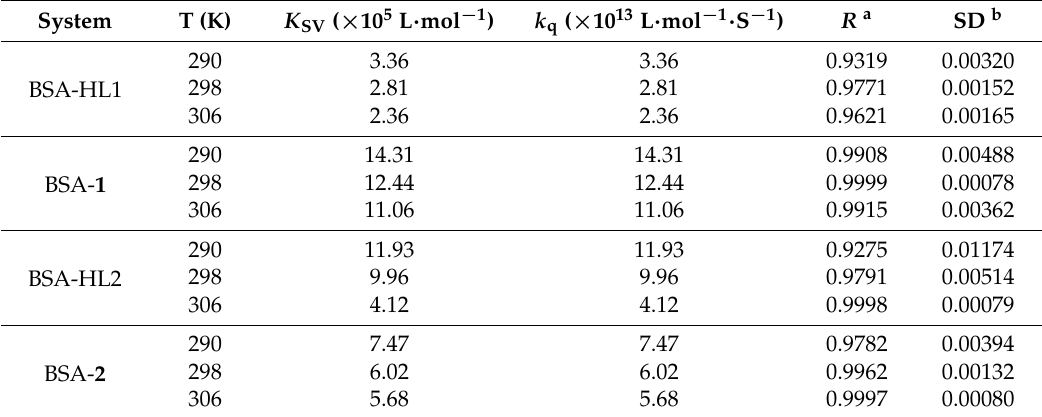
Figure 4. Stern-Volmer plots of the fluorescence quenching of BSA by HL1, HL2, 1 and 2 at different temperatures: 290 K, 298 K, 306 K. Table 5. The Stern-Volmer quenching constants of BSA by HL1, HL2, 1 and 2 at different temperature: 290 K, 298 K, 306 K.